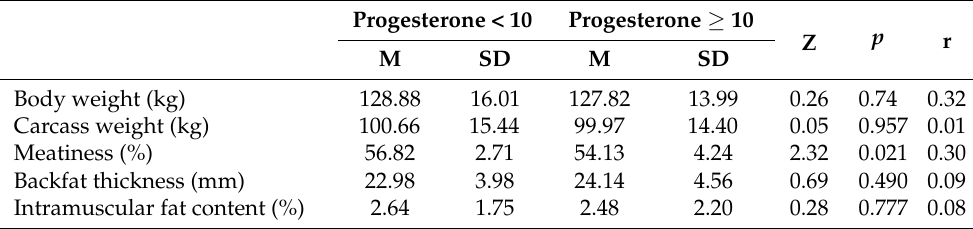
Table 2. Influence of progesterone level (ng/mL) on selected slaughter parameters of gilts carcasses.